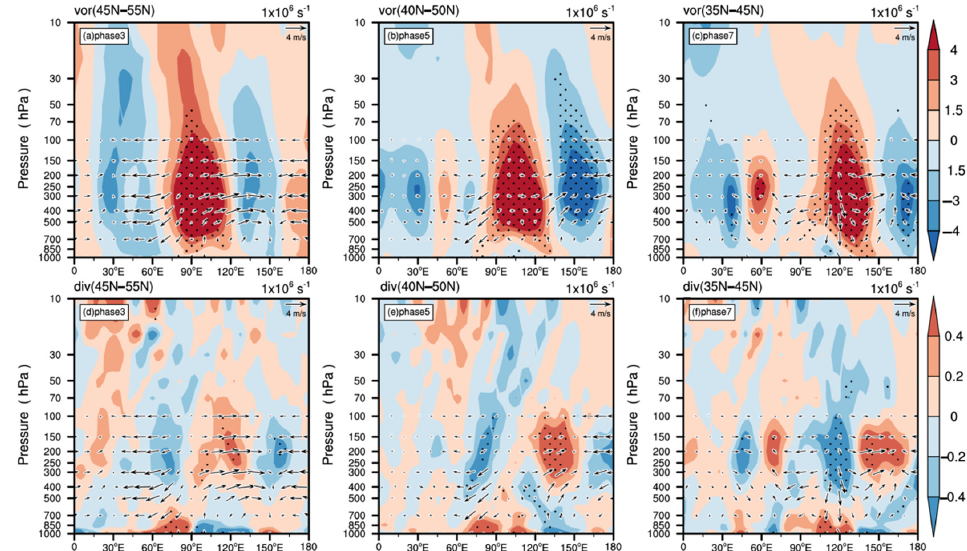
Figure 8. ( a – c ) Height–longitude profiles of meridional average 10–20 d low frequency vorticity, and ( d – f ) divergence along the latitudes 45–55° N, 40–50° N, and 35–45° N at phases 3, 5, and 7, respectively (shaded, unit: 1 0 − 5 s − 1 ,dotted area encloses regions of larger than 0.01 significance) and 10–20 d low frequency wind (vector, unit: